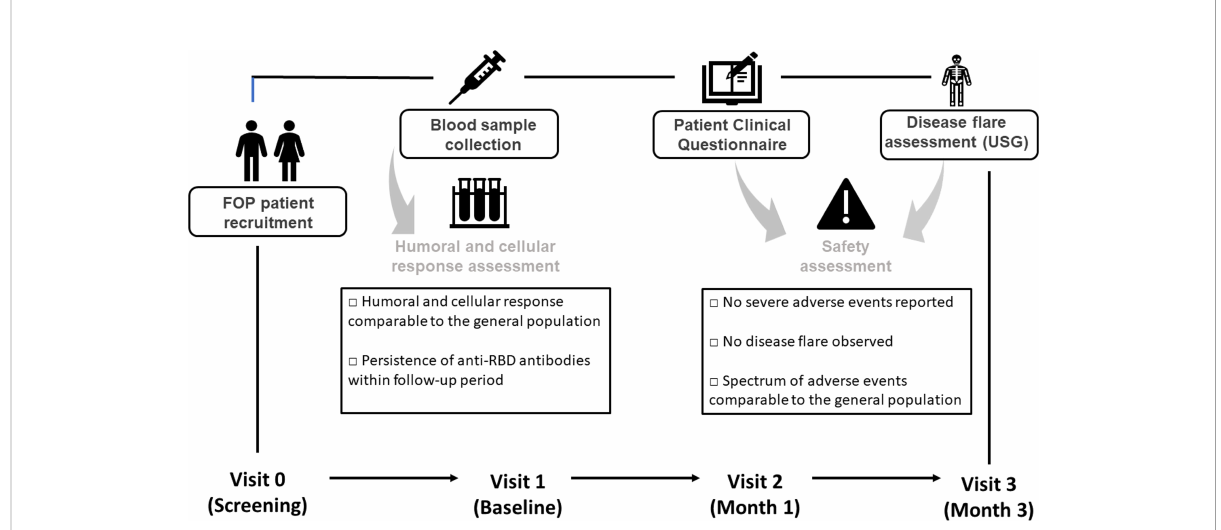
FIGURE 1 Timeline of the scheduled visits after vaccination. Immunization was performed according to International Clinical Council on Fibrodysplasia ossi fi cans progressiva (ICC on FOP) Guidelines